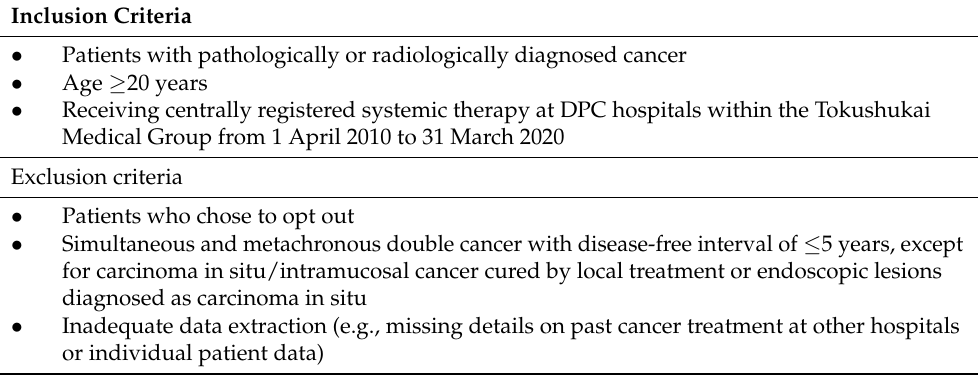
Table 1. Inclusion and exclusion criteria.